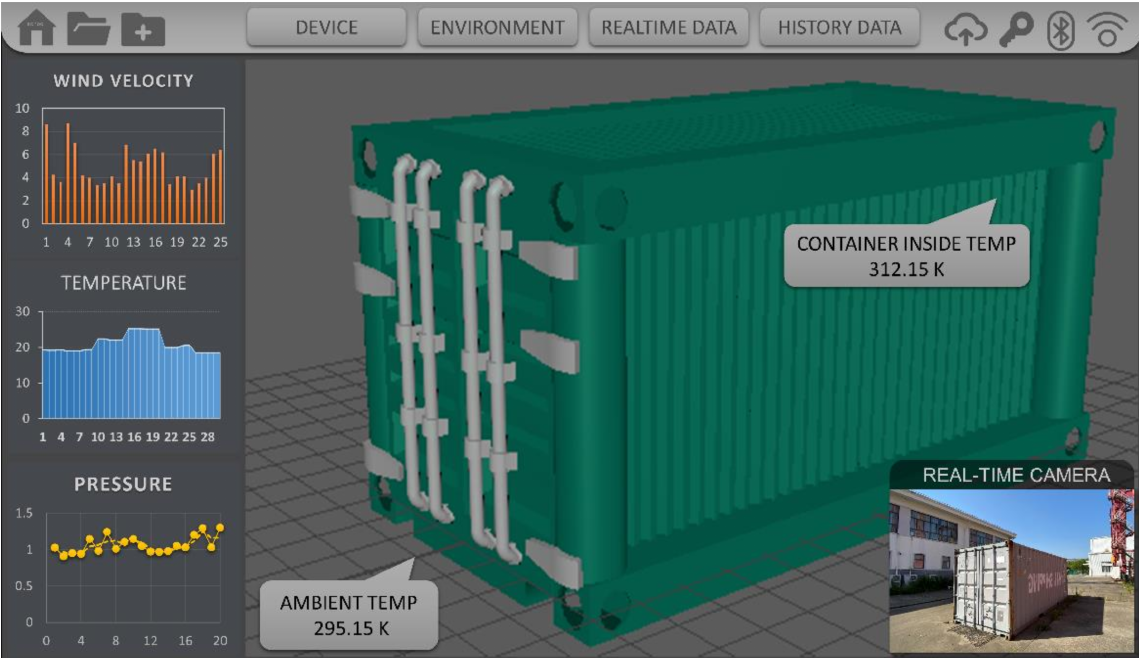
Figure 7. DT-driven platform for shipping cargo container in the operation